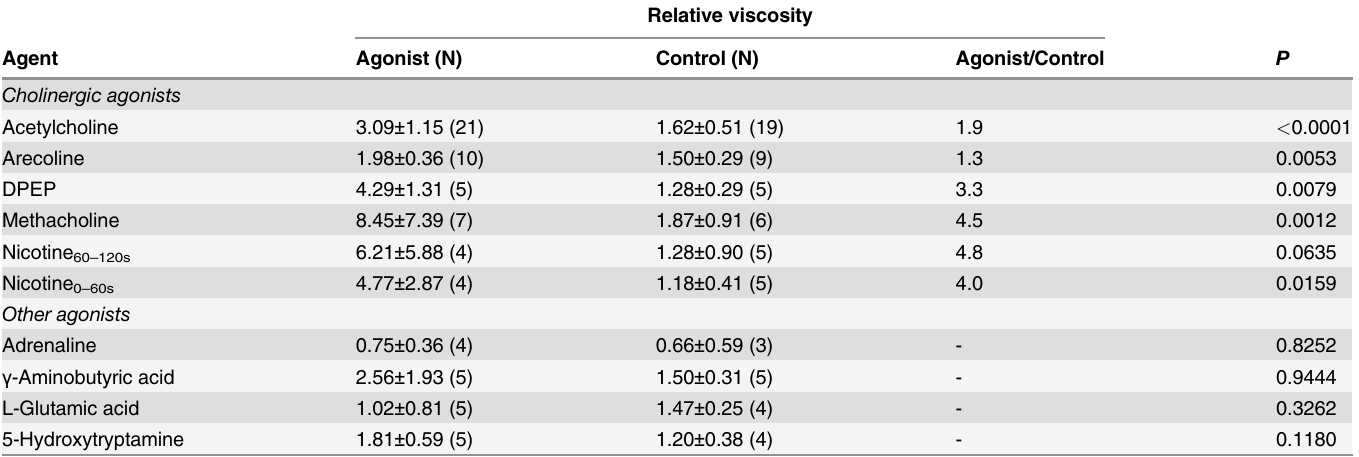
Table 4. Effects of pharmacological agents on the relative viscosity of P . lividus